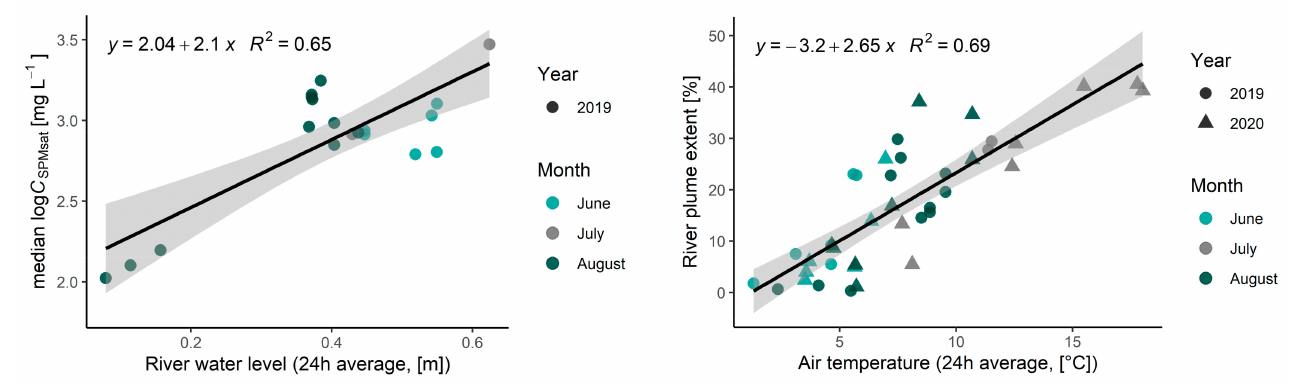
Figure 6. Linear model showing the analysed relationship of the satellite derived river plume extent ( C SPM > 30 mg L − 1 ) and air temperature ( ◦ C) as well as the river water level and median values sat of logC SPM . The equation and R 2 , the coefficient of determination, are given. Colours and shapes represent the month and year of the satellite acquisition,